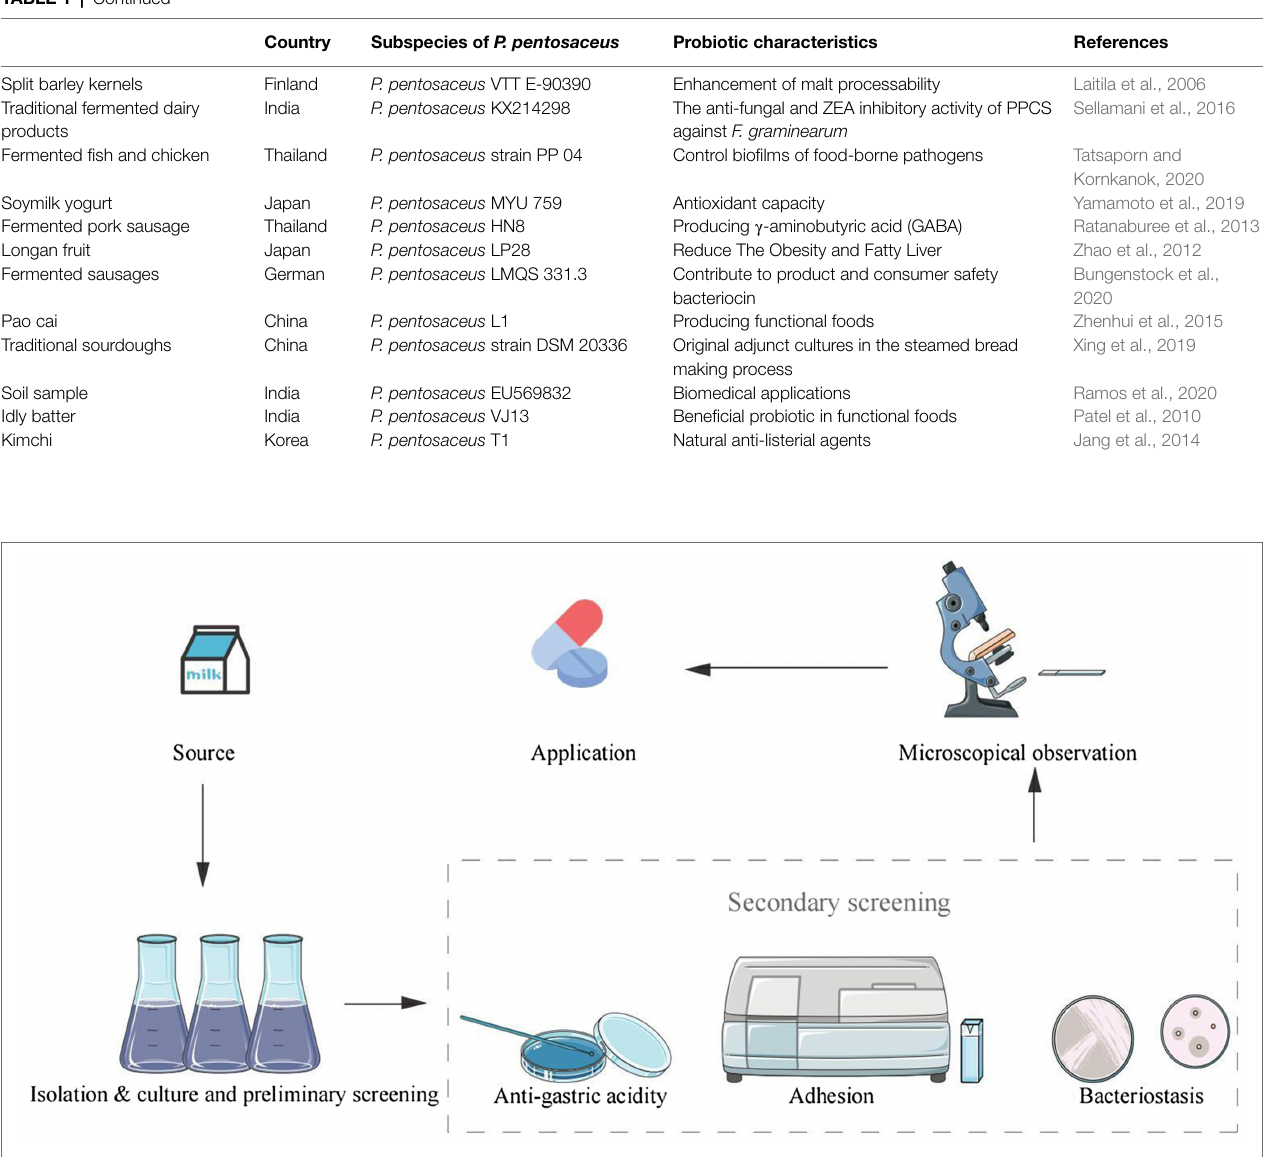
FIGURE 2 | P. pentosaceus strain screening